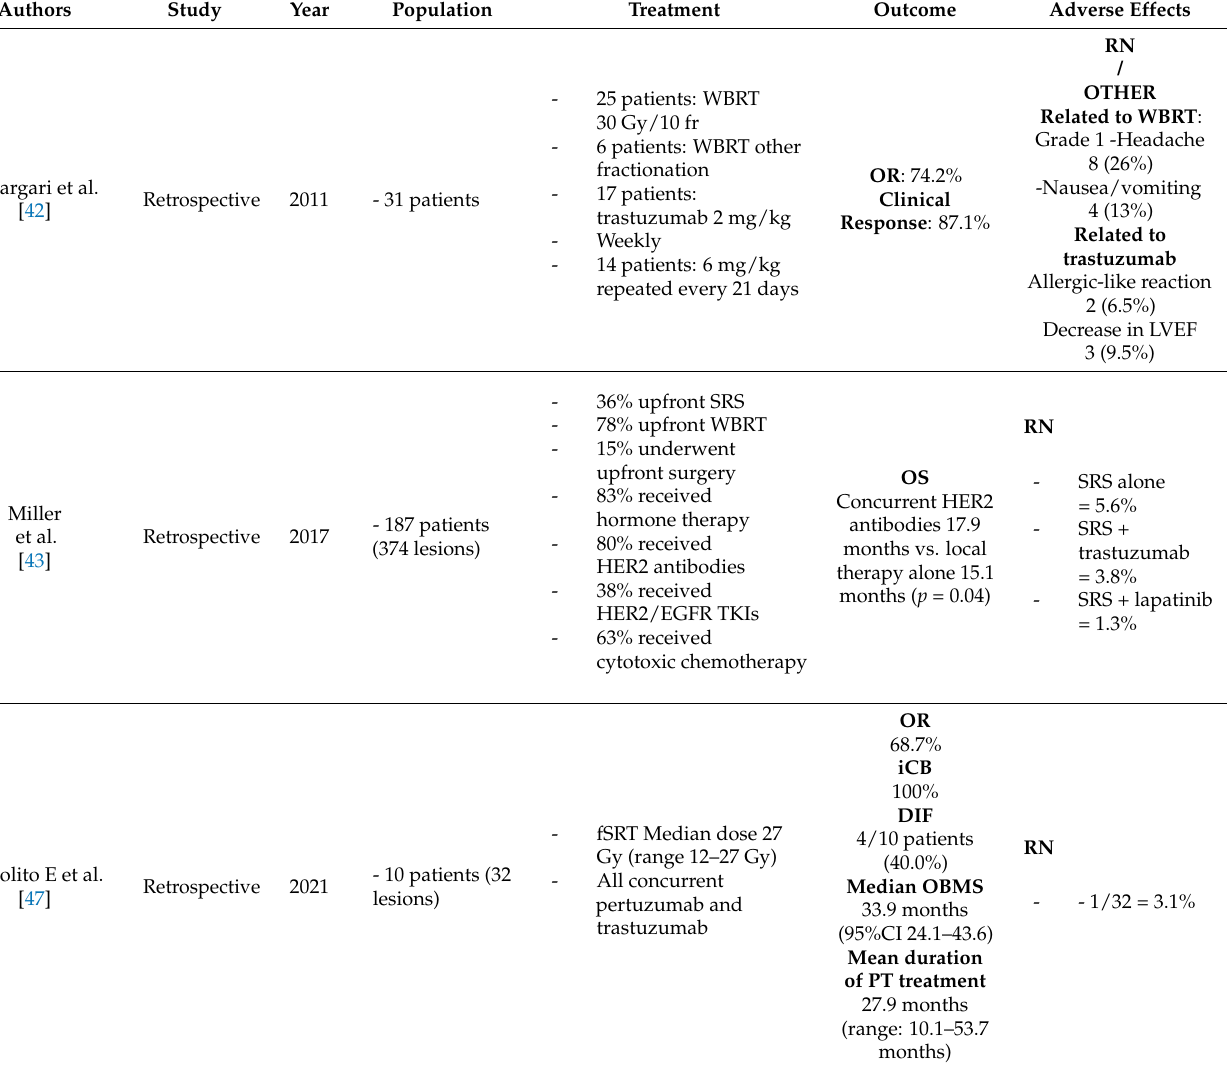
Table 1. Combination of systemic therapy and brain RT: trastuzumab,